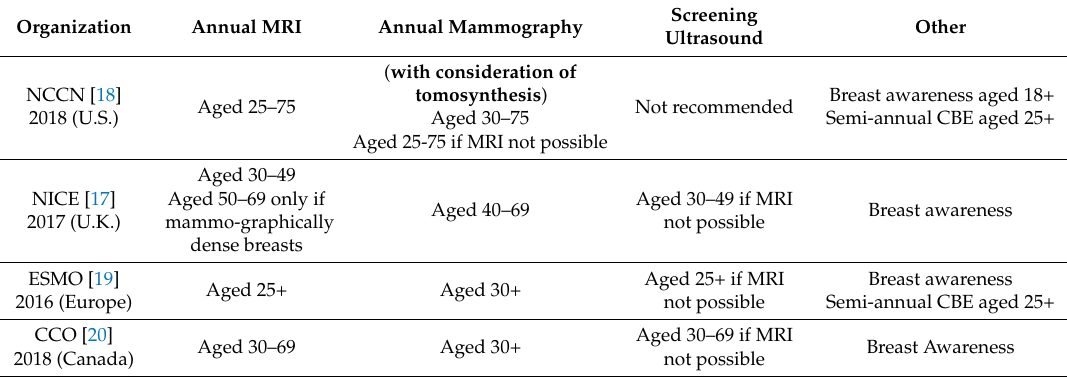
Table 1. Expert recommendations for screening BRCA mutation carriers for breast